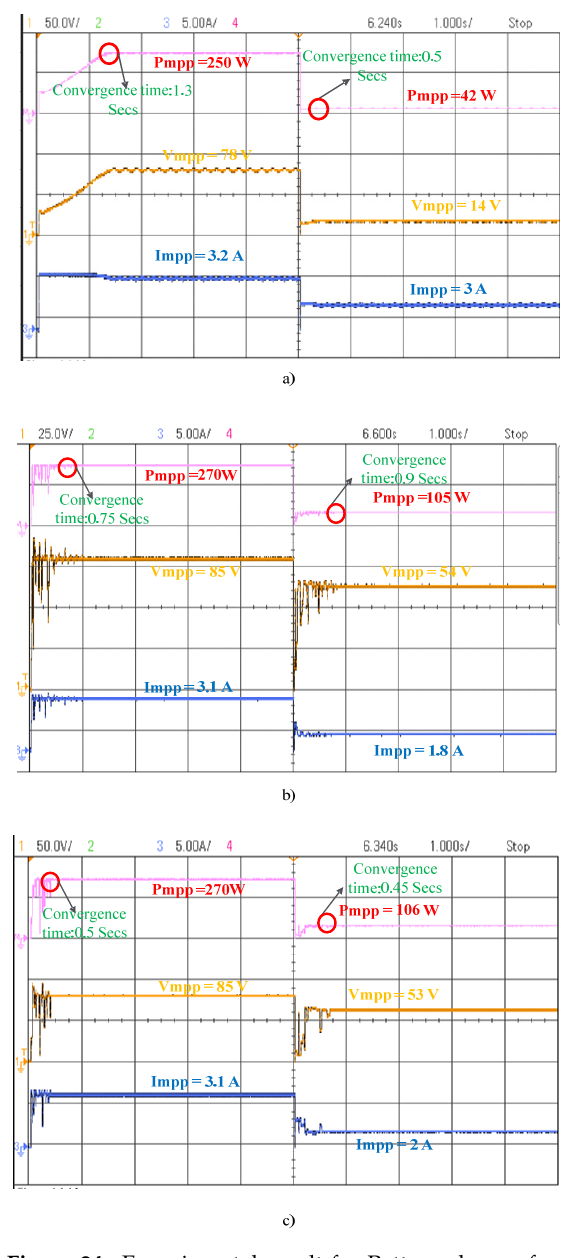
Figure 24. Experimental result for Pattern change from uniform shading to partial of Pattern 5: ( a ) P&O, ( b ) PSO, ( c ) SHO.